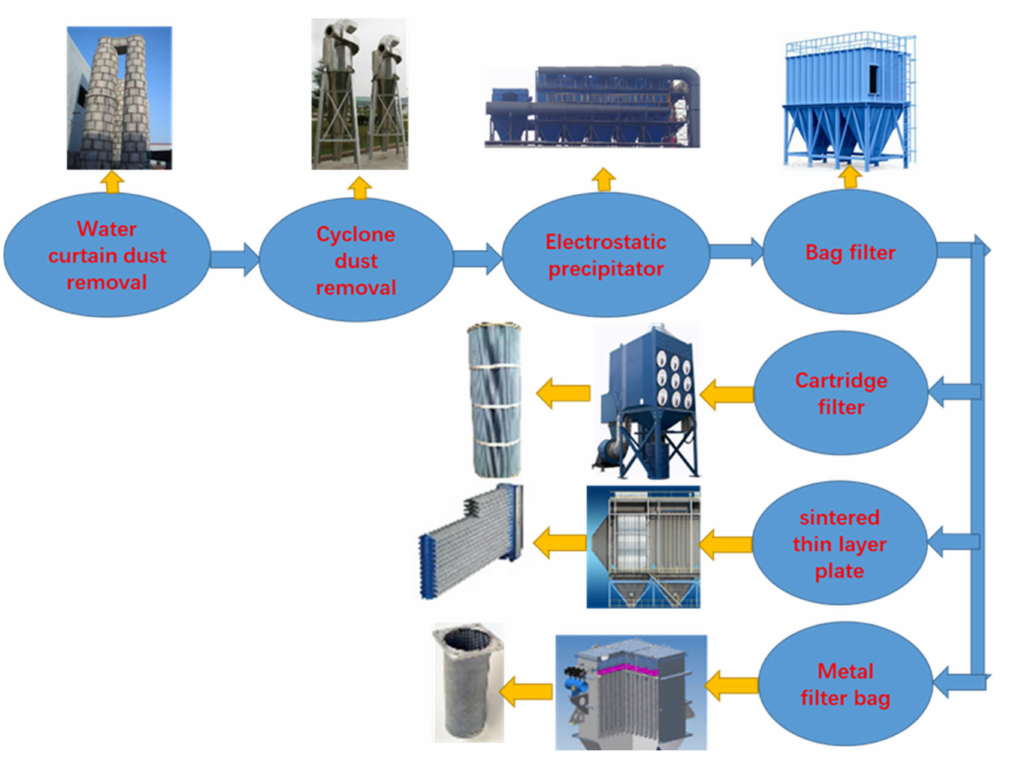
Figure 7. The evolution of dust collectors.